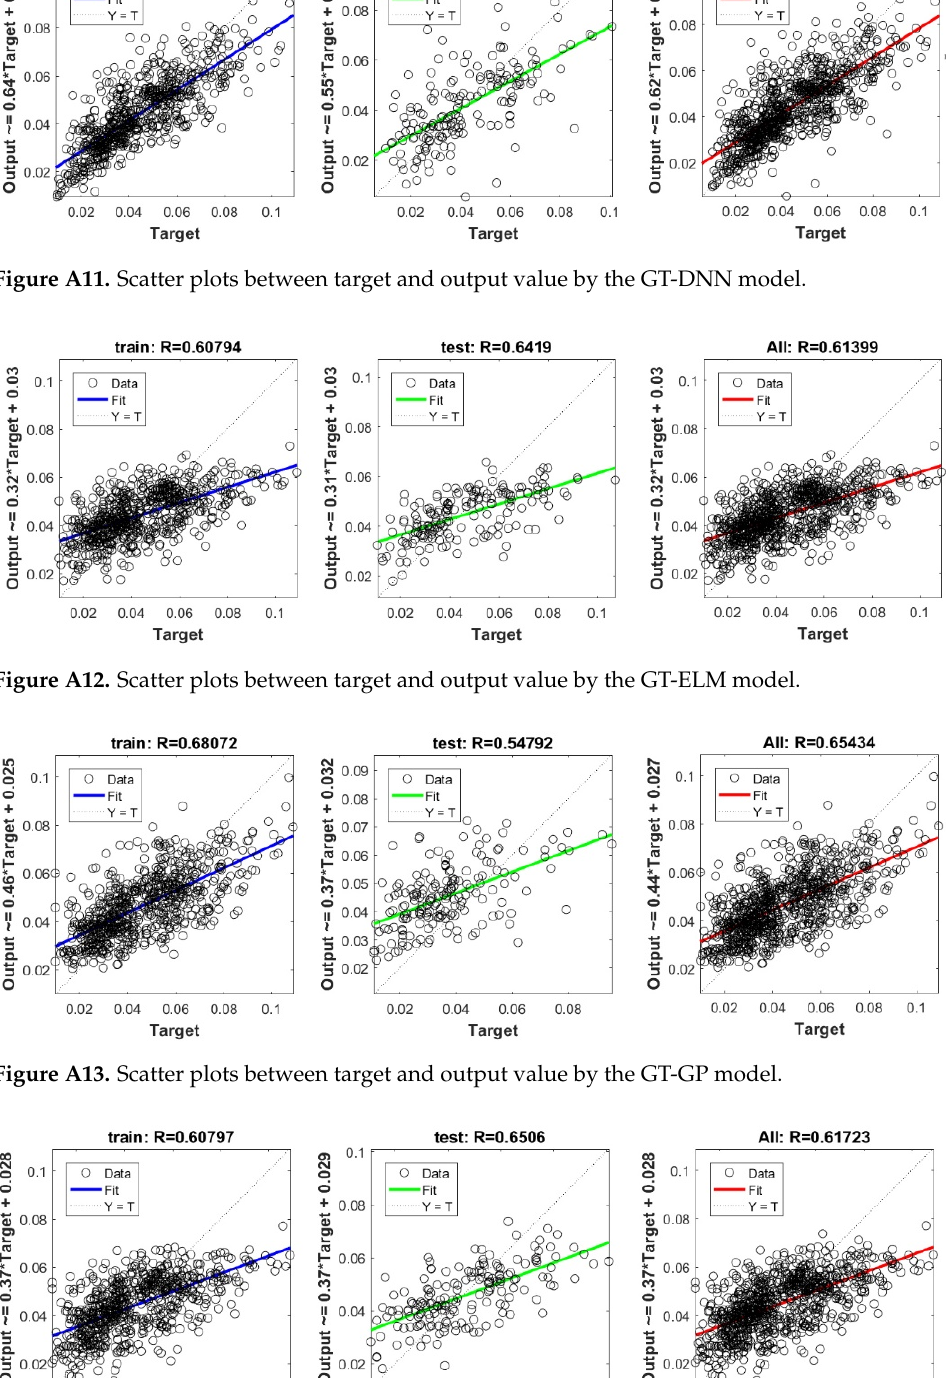
Figure A14. Scatter plots between target and output value by the GT-KRidge model.